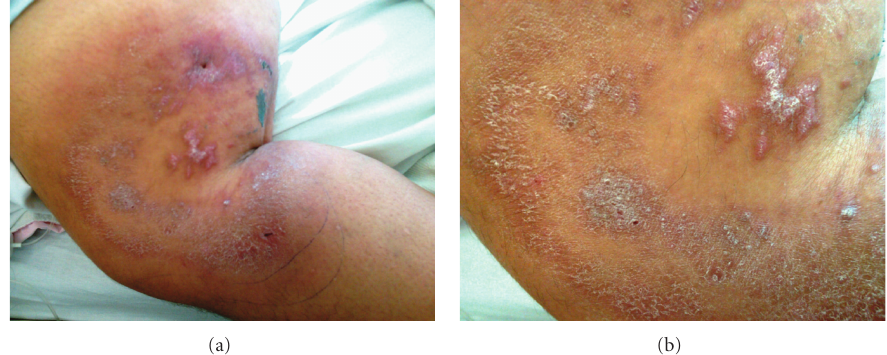
Figure 1: Cutaneous lesions on the thigh, which had been present for 8 months with recent worsening in severity.